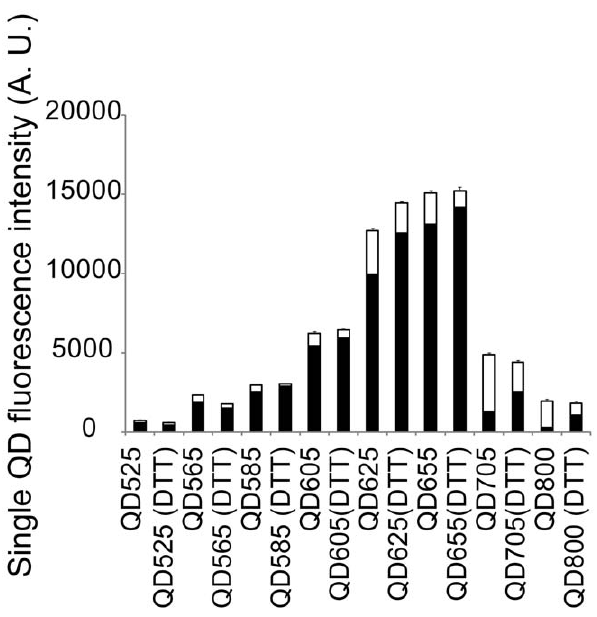
Figure 3. Mean fluorescence intensities and fractional ‘‘on’’ time of single QDs showing the ensemble average mean ( + s.e.m) integrated fluorescence intensity, I QDon , (full bar) and fractional on (filled bar)/off (unfilled bar) times, F QDon/off of all QD colors with and without 1 mM DTT. A summary of the values for all QD colors and conditions is given in Table